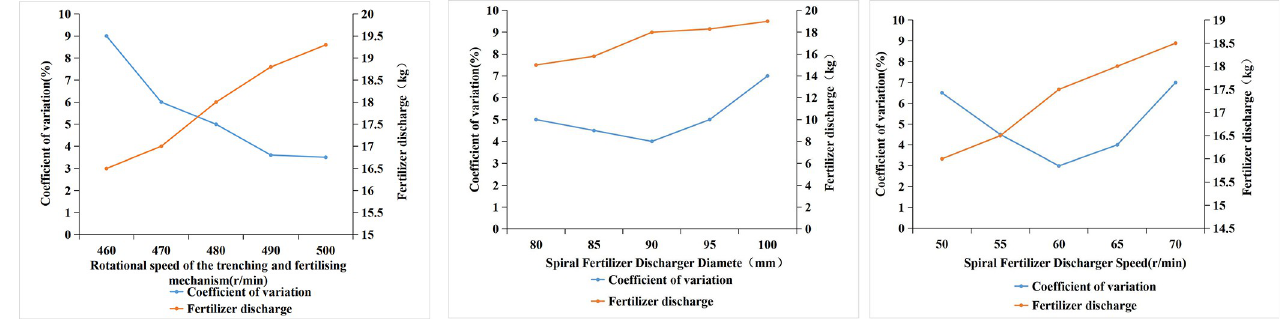
Fig 7. Single-factor test.